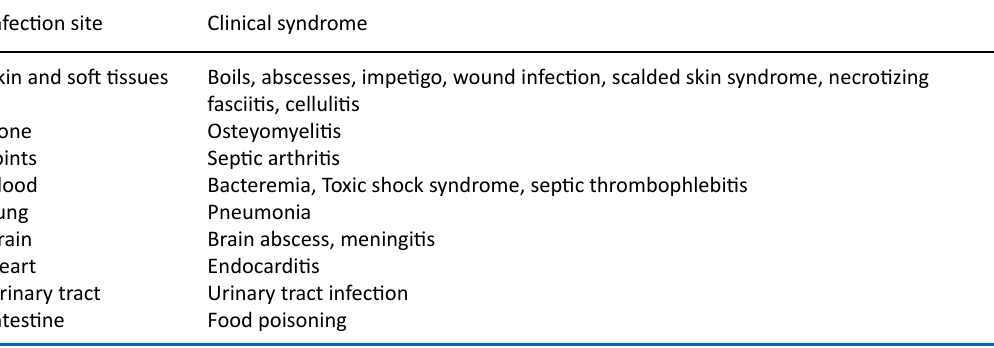
table 1. Human infections caused by Staphylocccus aureus Infection site Clinical syndrome Skin and soft